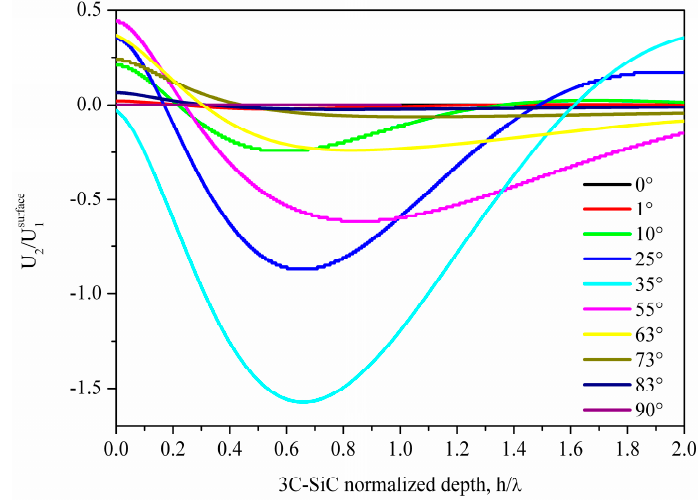
Figure 11. Variation of the normalized shear horizontal displacement component vs. the SiC depth, being the angle off the <001> axis the running parameter.